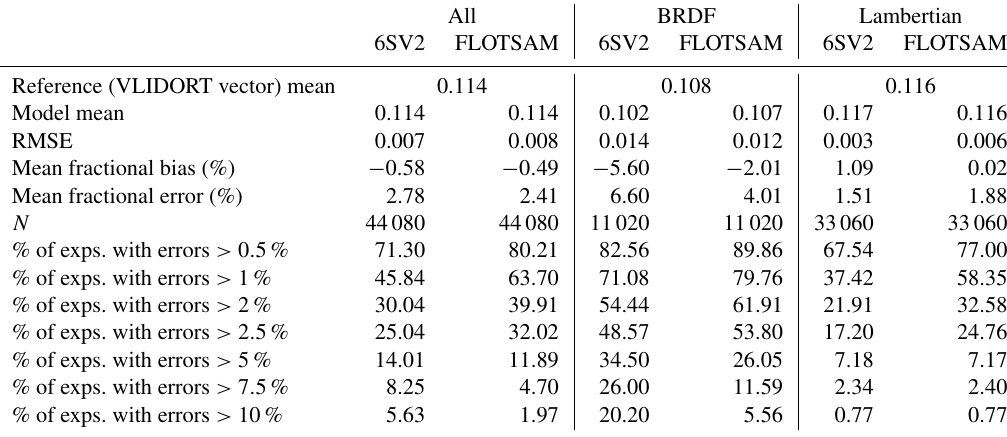
Table 4. Same as Table 3 but for the 6SV2 and FLOTSAM models. All BRDF Lambertian 6SV2 FLOTSAM 6SV2 FLOTSAM Reference (VLIDORT vector) mean